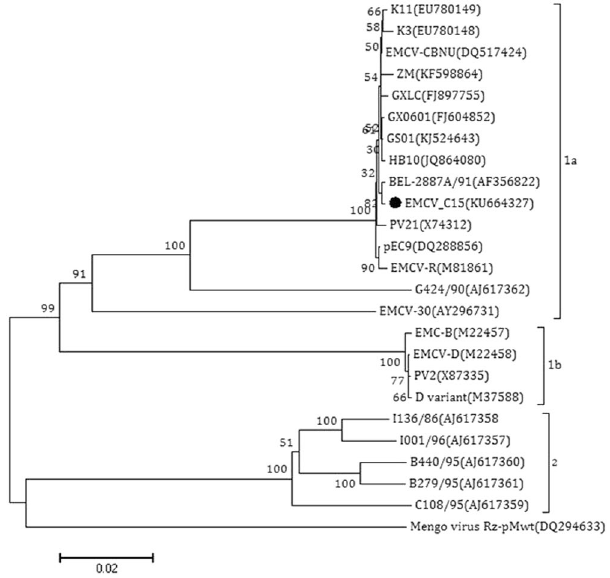
Figure 6. Phylogenetic analysis of isolate EMCV-C15 based on the complete ORF of 6879 nt. A phylogenetic tree was constructed using MEGA5.1 software. Mengovirus served as an outgroup. Bootstrap values obtained from 1,000 replicates are shown at the major nodes. The isolate identified in this study is indicated with solid